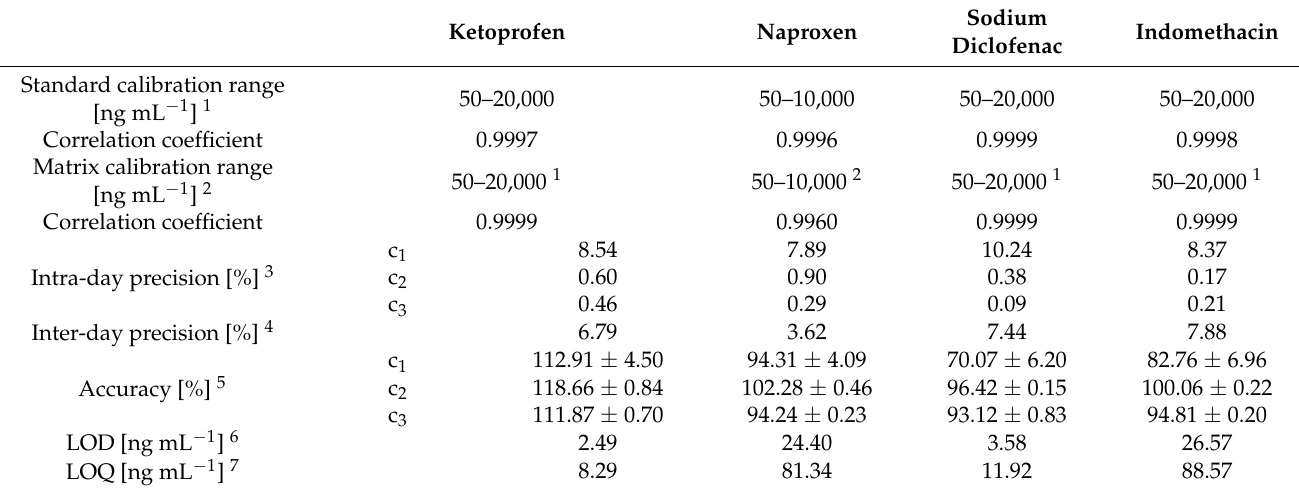
Table 2. HPLC method validation results.